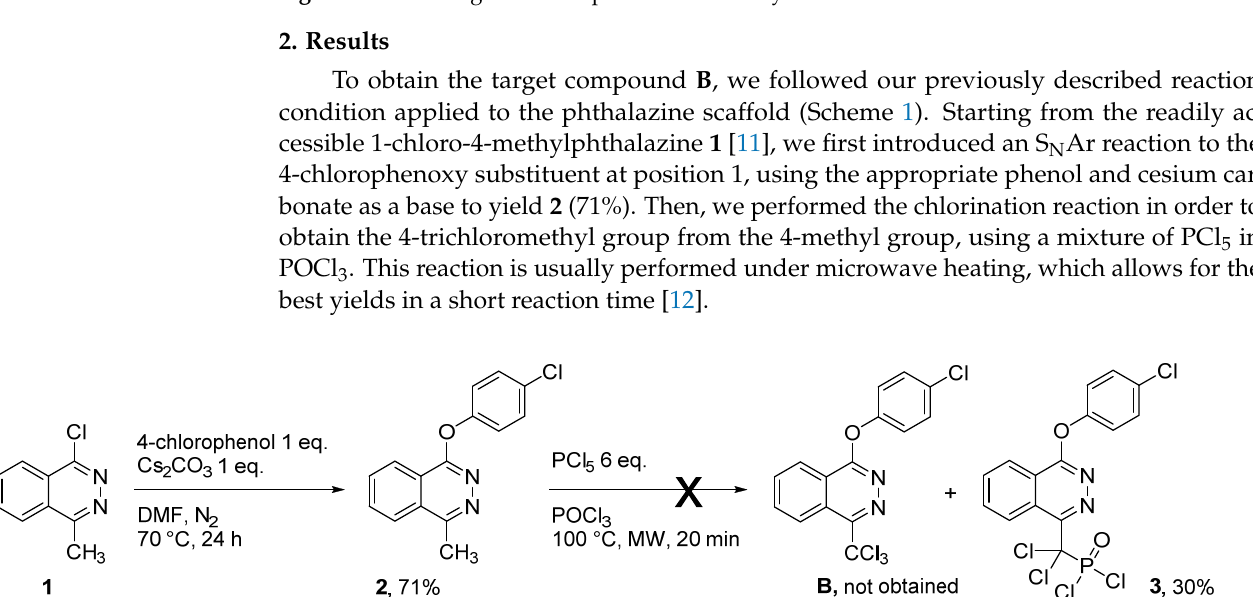
Figure 2. Some drugs based on phthalazine moiety.